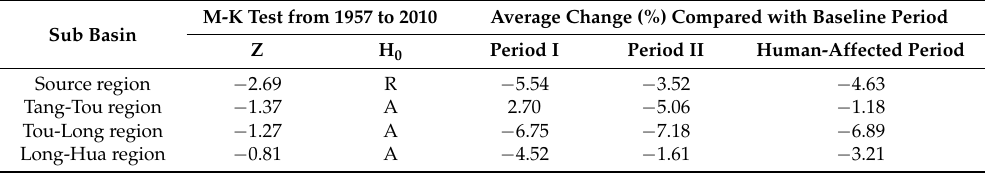
Table 2. MK results and average change of the percentage of flood-season precipitation in four regions of YRB.